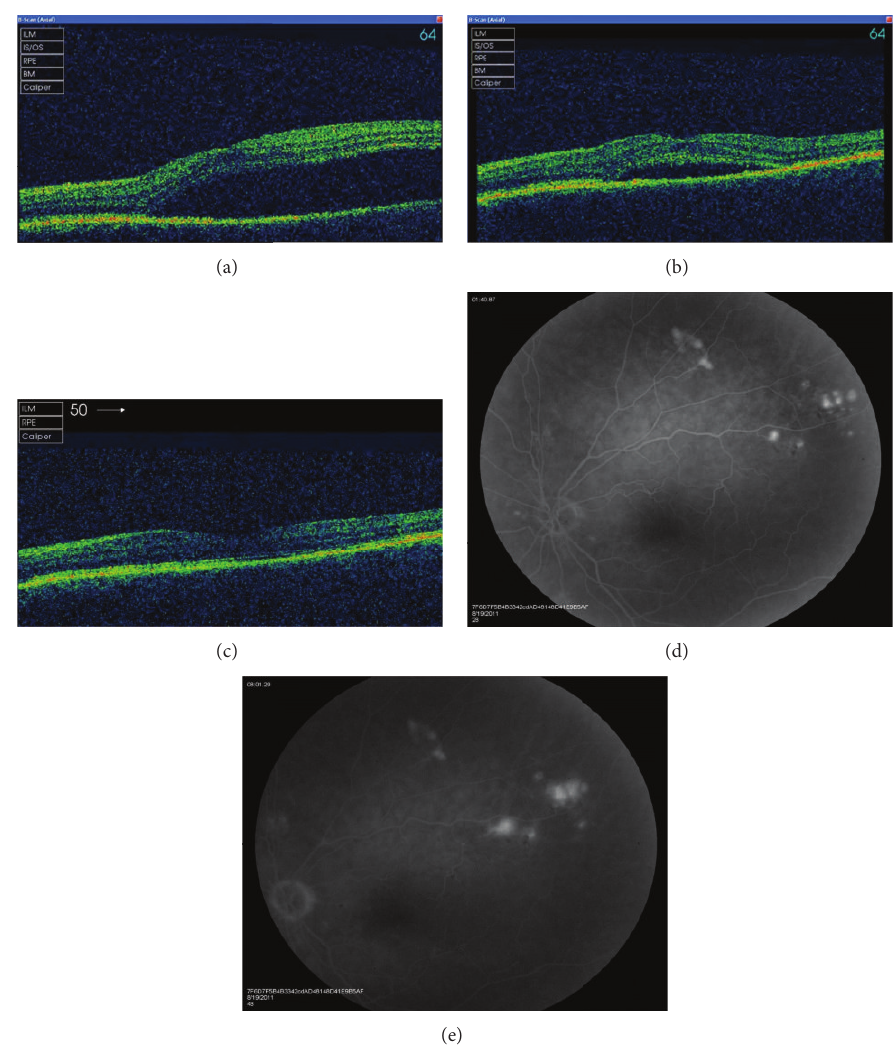
Figure 1: ((a), (b), (c)) Optical coherence tomography of the left macula at presentation, 6 weeks and 6 months showing complete resolution of subretinal fluid with tapering of corticosteroids. ((d), (e)) Fundus fluorescein angiogram of the left eye showing multiple areas of focal pinpoint hyperfluorescence with progressive leakage in the late